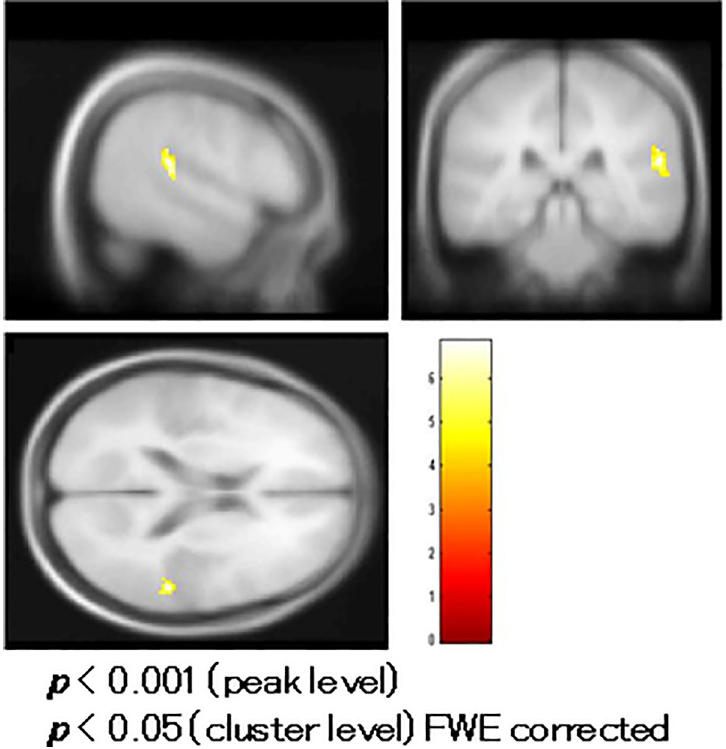
Fig 6. Correlation of functional magnetic resonance imaging (fMRI) with mismatch negativity (MMN) in patients. Blood oxygenation level-dependent (BOLD) activity in the right superior temporal gyrus significantly correlated with MMN amplitudes at the Fz